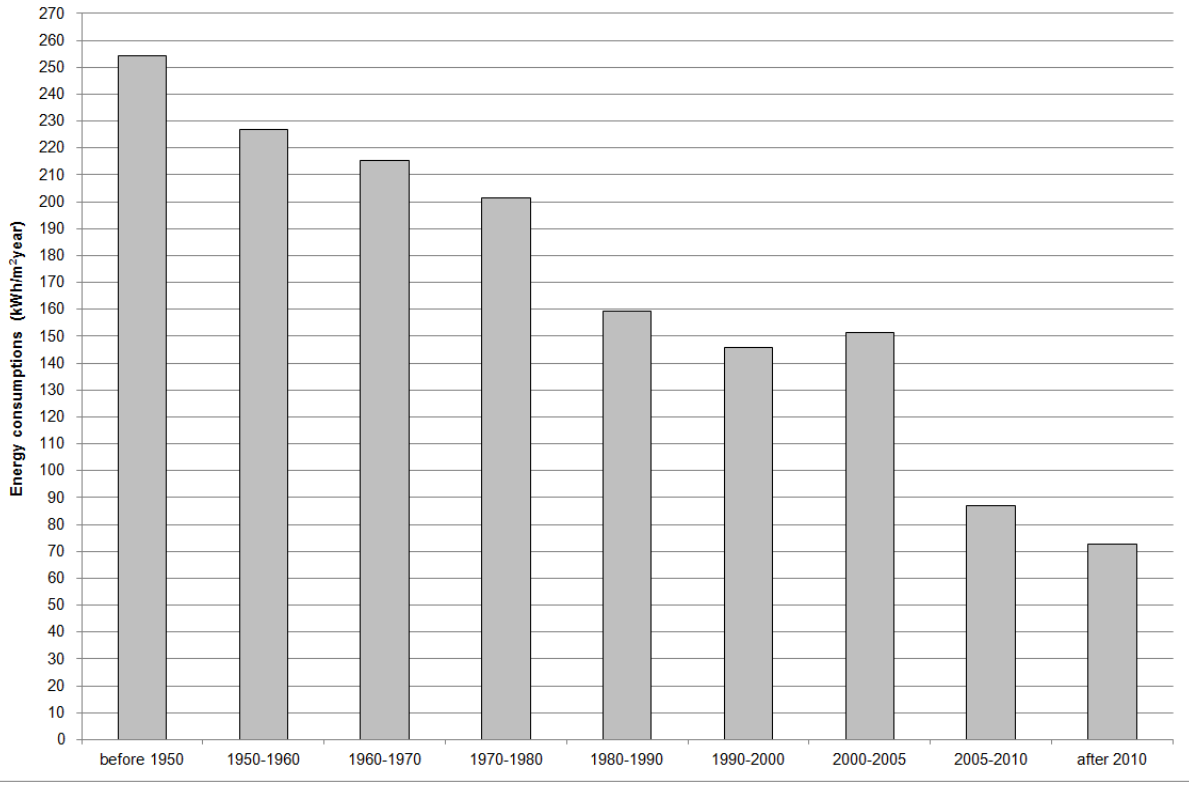
Figure 5. Energy consumption of Umbrian buildings as a function the of year of